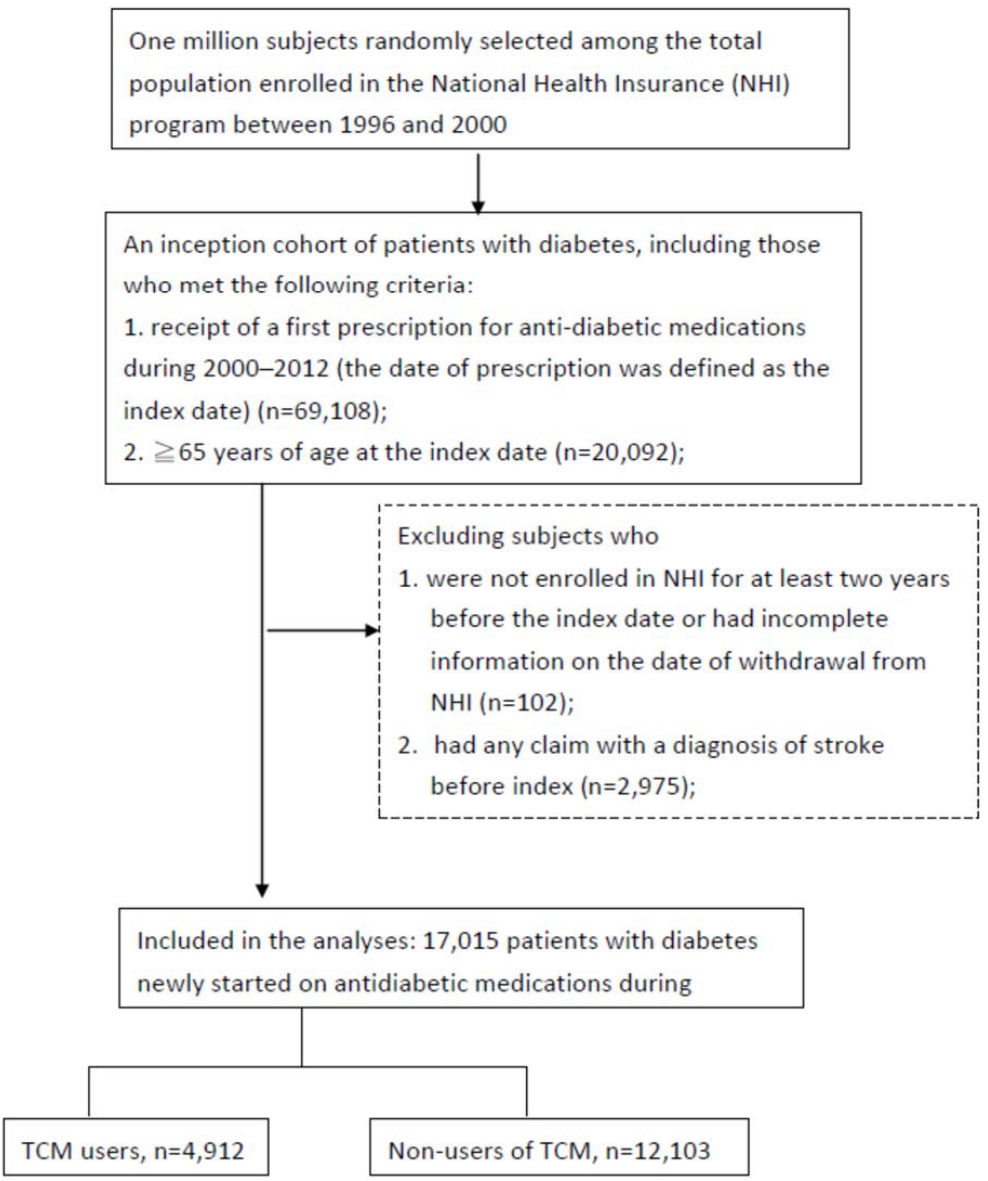
Figure 1. Flowchart of the selection of the study subjects. TCM: traditional Chinese medicine